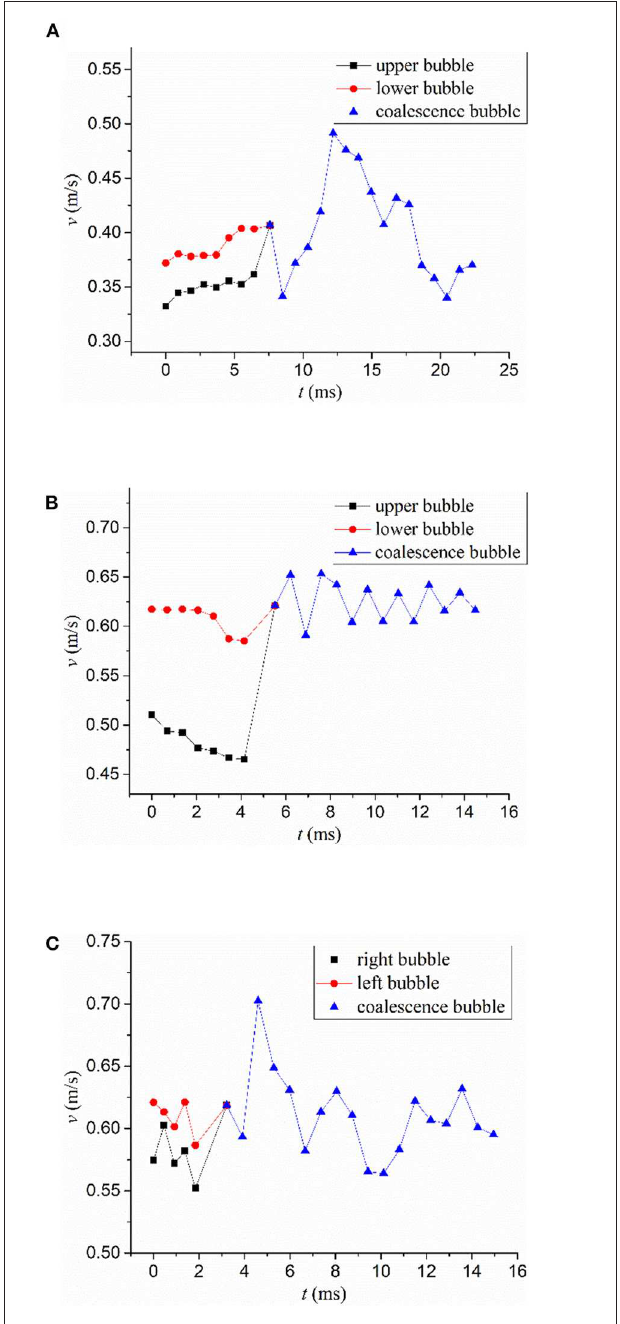
FIGURE 4 | Bubble velocity variation with time. (A) q = 114.3 kW · m − 2 ; = 31 ◦ C; G = 333.9 kg · m − 2 · s − 1 , (B) q = 212.2 kW · m − 2 ; 1 T 1 T sub,in